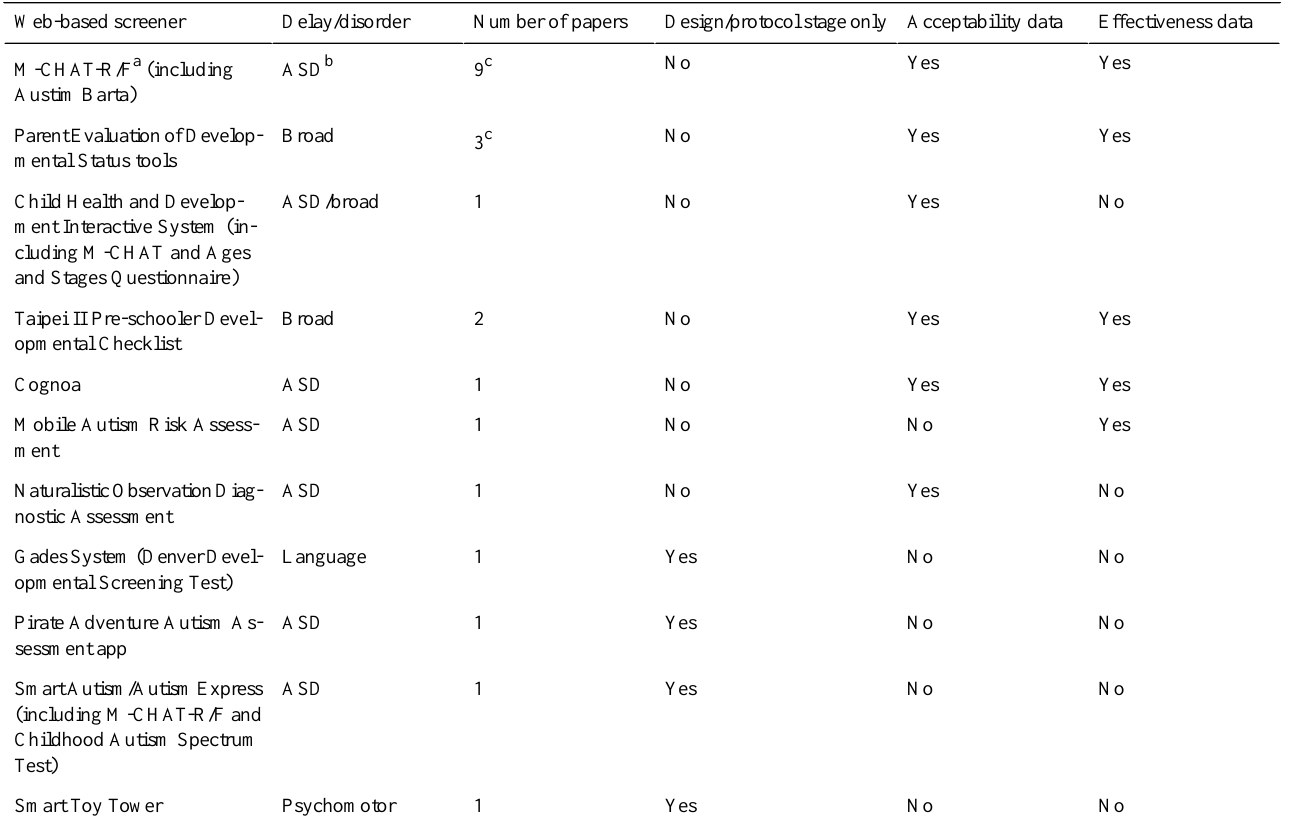
Table 1. A summary of identified web-based developmental surveillance/screening tools, including the targeted developmental delay and the availability of acceptability or effectiveness